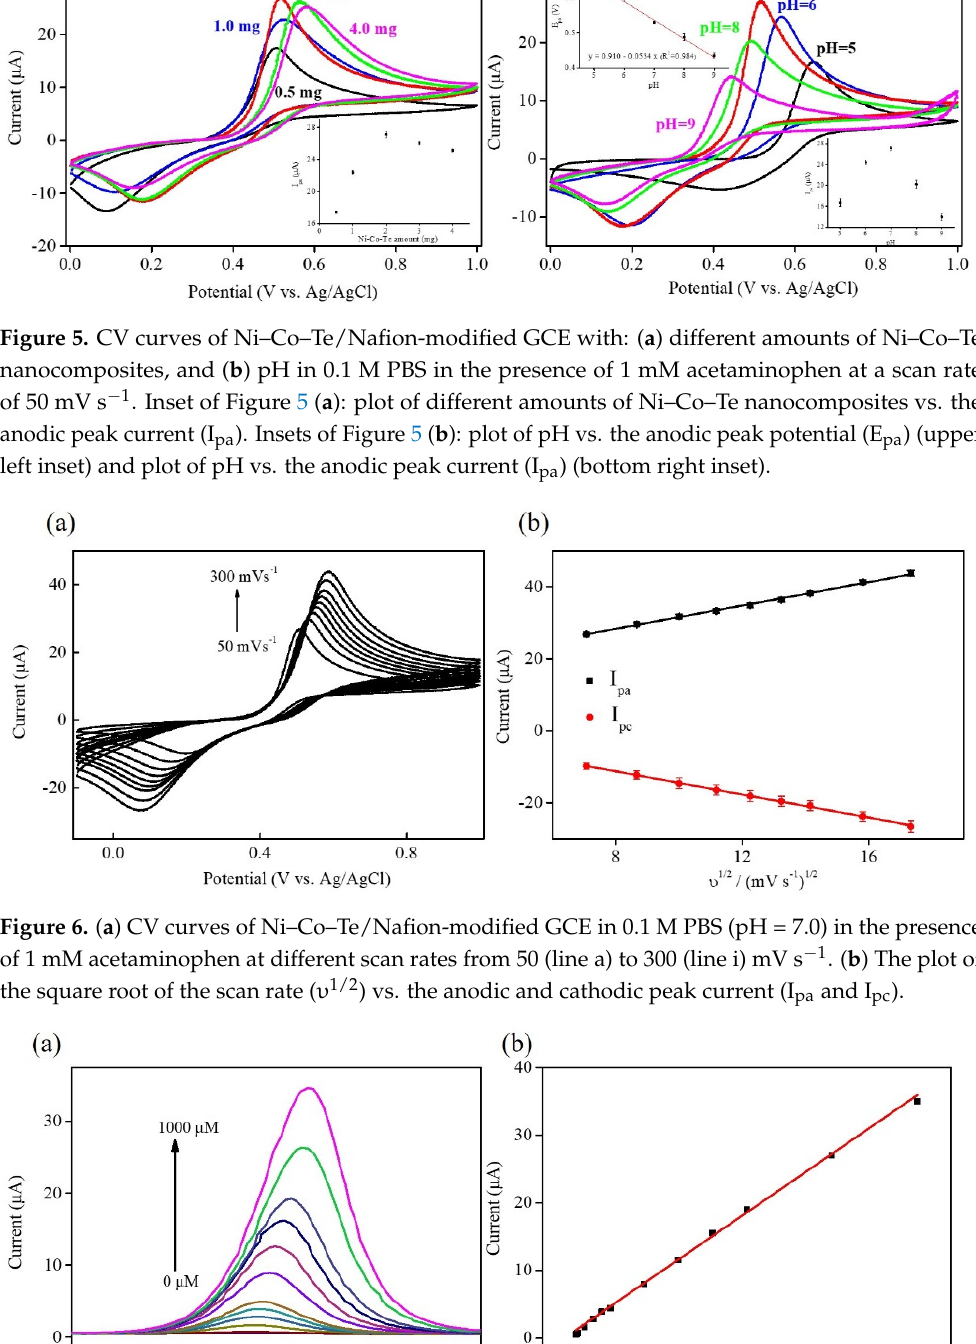
Chemosensors 2022 , 10 , x FOR PEER REVIEW